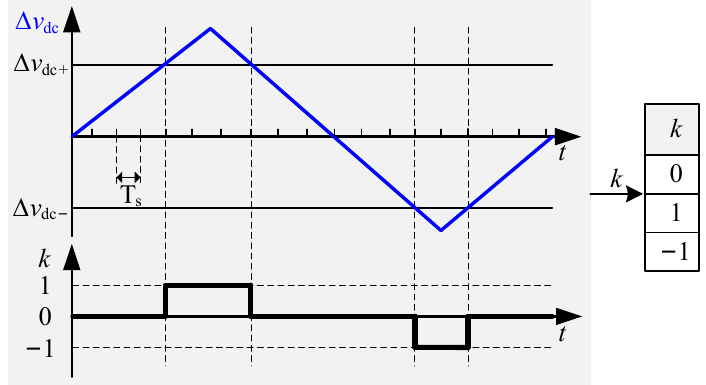
Figure 3. Acquisition method of the symbolic variable k .